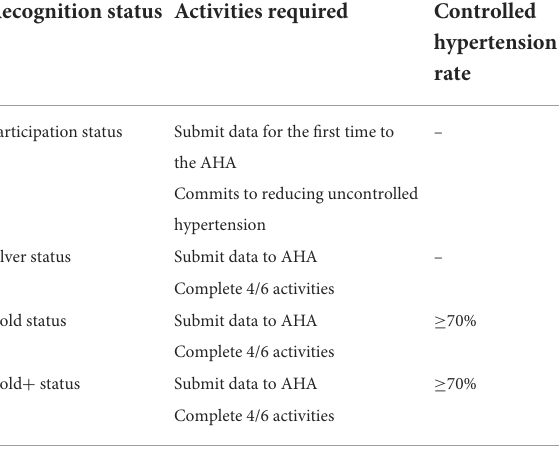
TABLE 1 Target:BP recognition levels based on evidence-based blood pressure activities